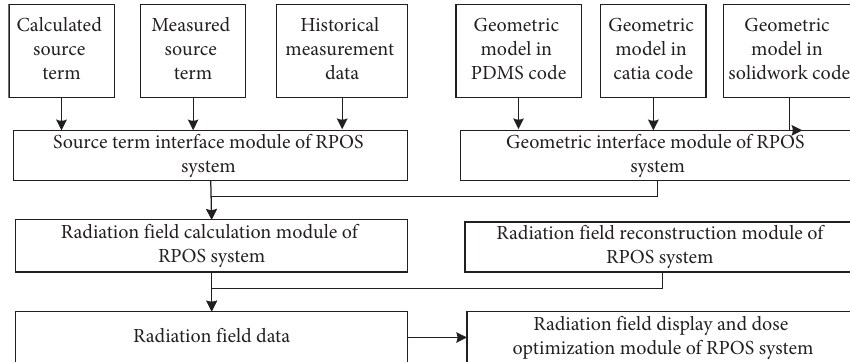
Figure 1: The system architecture of RPOS system.